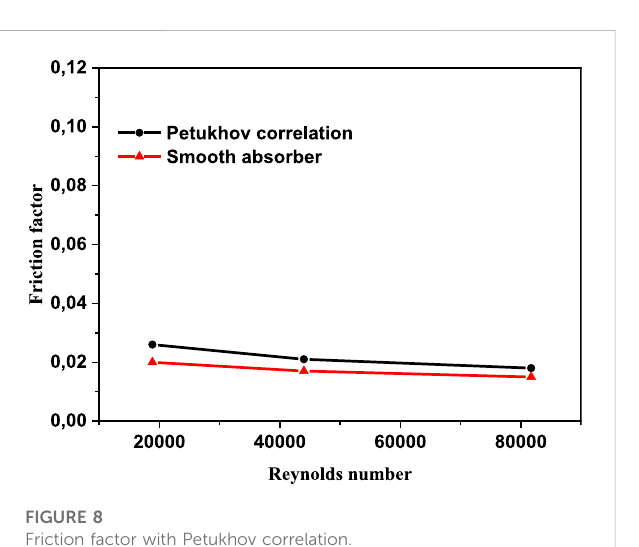
FIGURE 10 Variationinabsorbertube ’